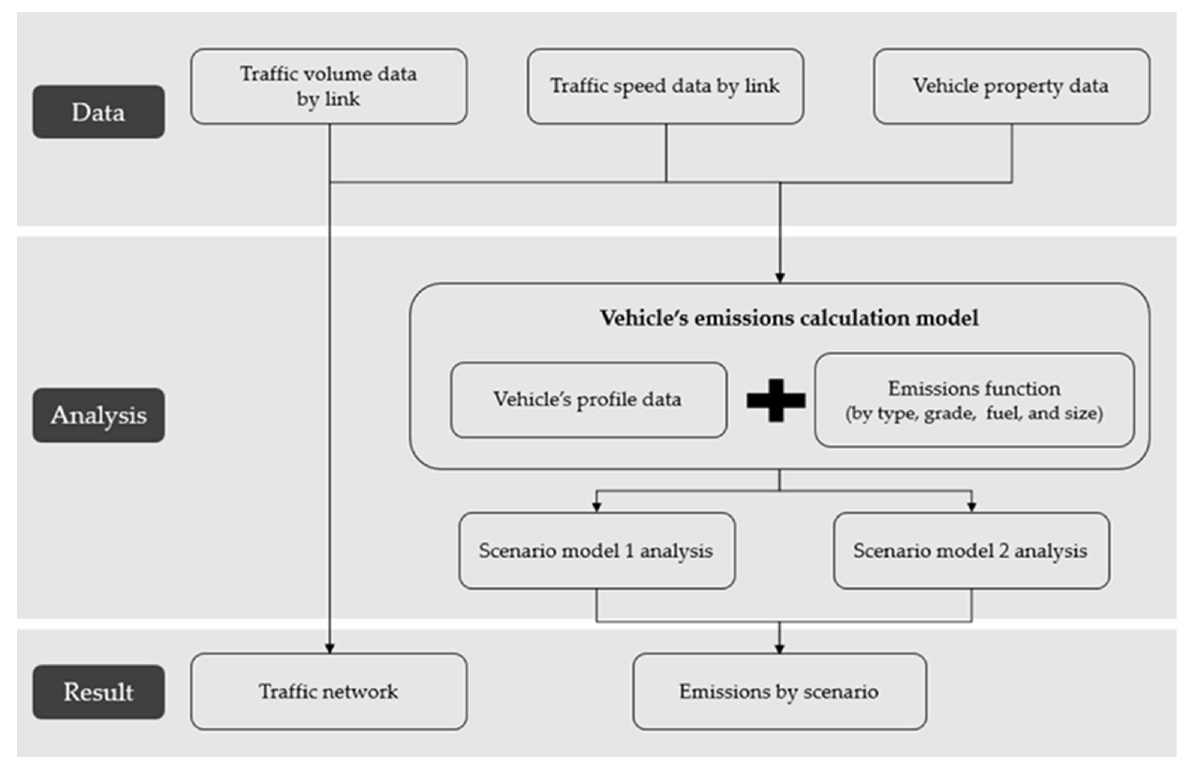
Figure 6. Emissions calculation process.